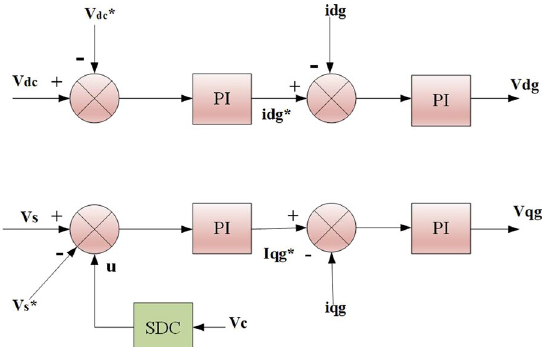
Fig. 6 With an auxiliary SSR damping at q-axis loop